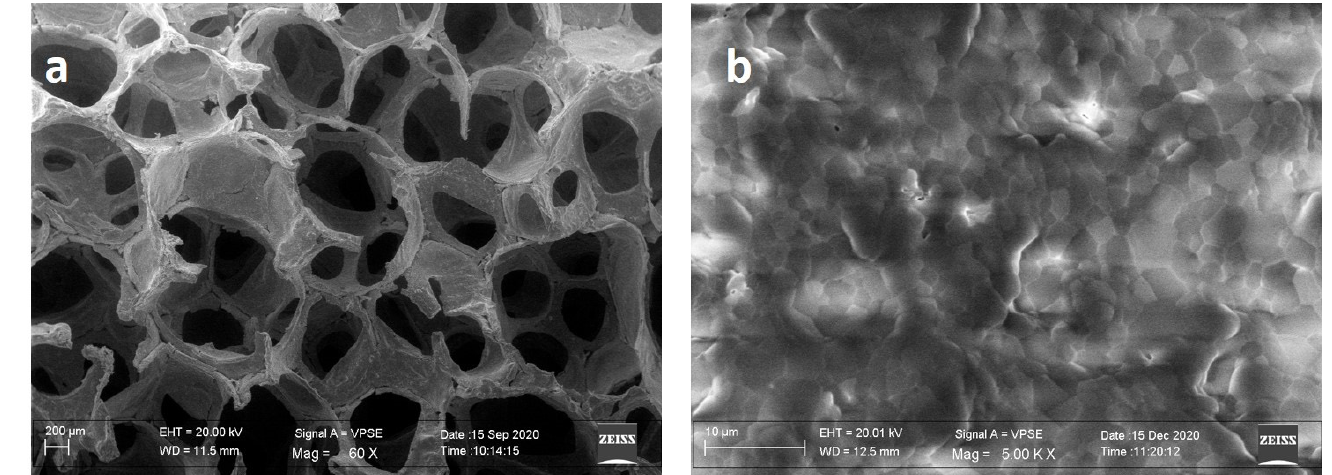
Figure 1. SEM image of HA-Si scaffold. ( a ) Macrostructure and ( b ) microstructure.